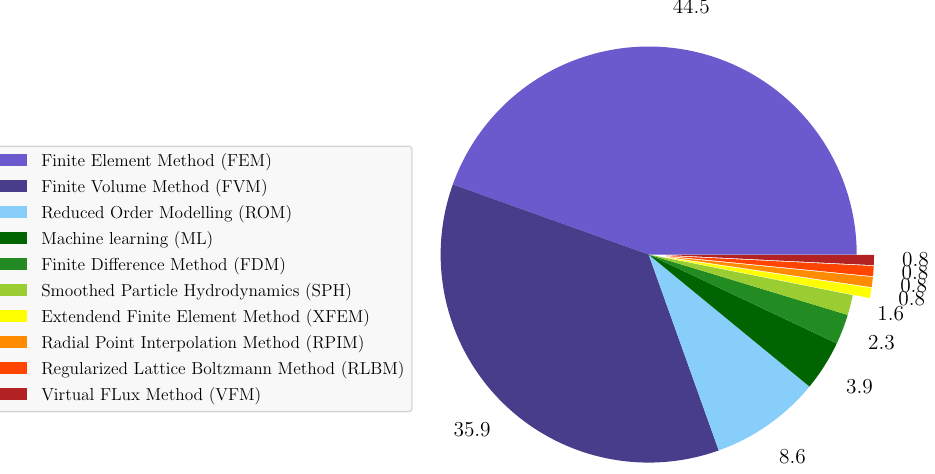
Figure 4. Relative frequency (values presented in percentage) of the identified numerical approaches. n = 115